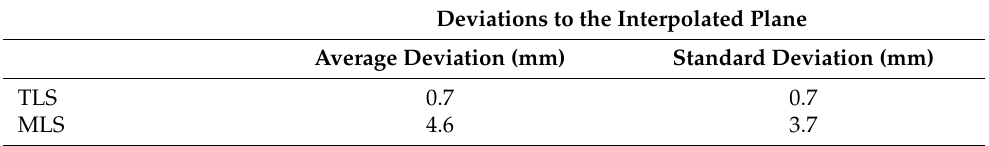
Table 4. Average values (in mm) and standard deviations (in mm) of the deviations between the clouds—from TLS and MLS—from the interpolated planes.